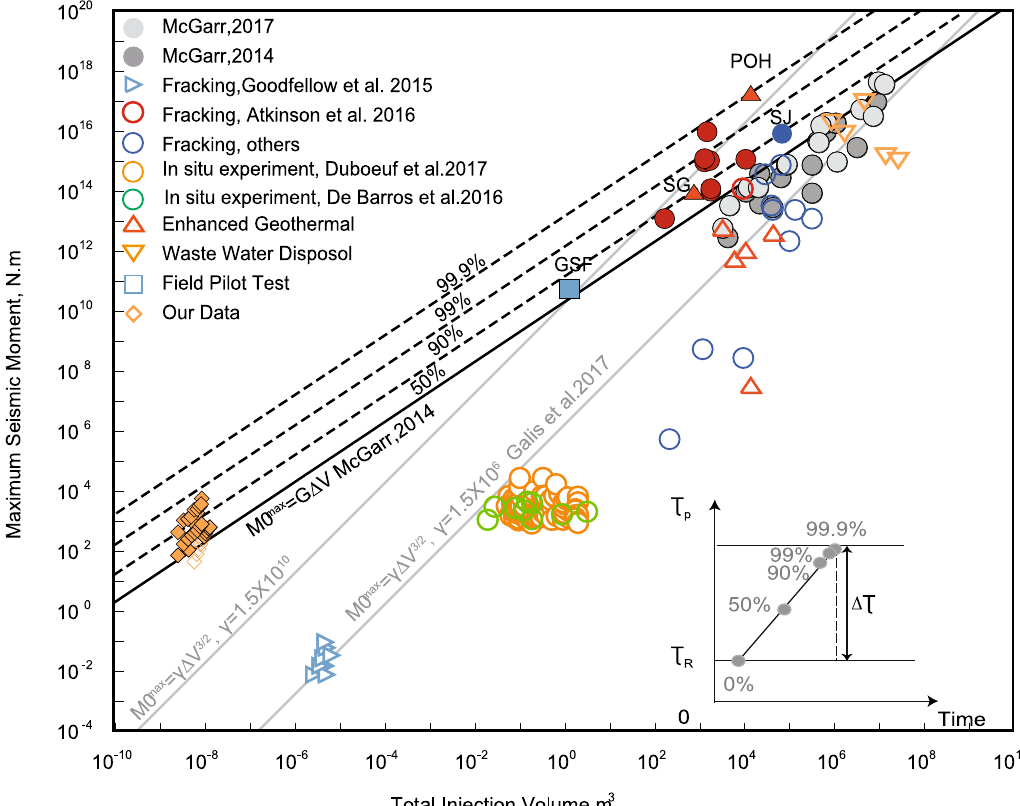
Fig. 3 Maximum seismic moment versus total injection volume for fl uid-injection-induced earthquakes. Black line de fi nes the upper limit of the seismic moment for assumed average stress. The black dashed lines represent solution with c values as shown in the lower-right inset. Gray solid lines represent maximum seismic moment and are added for completeness with two different γ